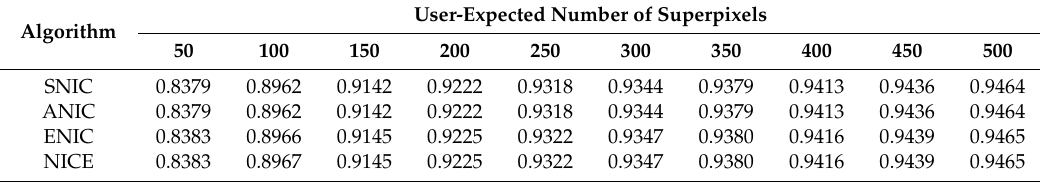
Table 3. Comparison of SNIC and the proposed three algorithms in terms of achievable segmentation accuracy